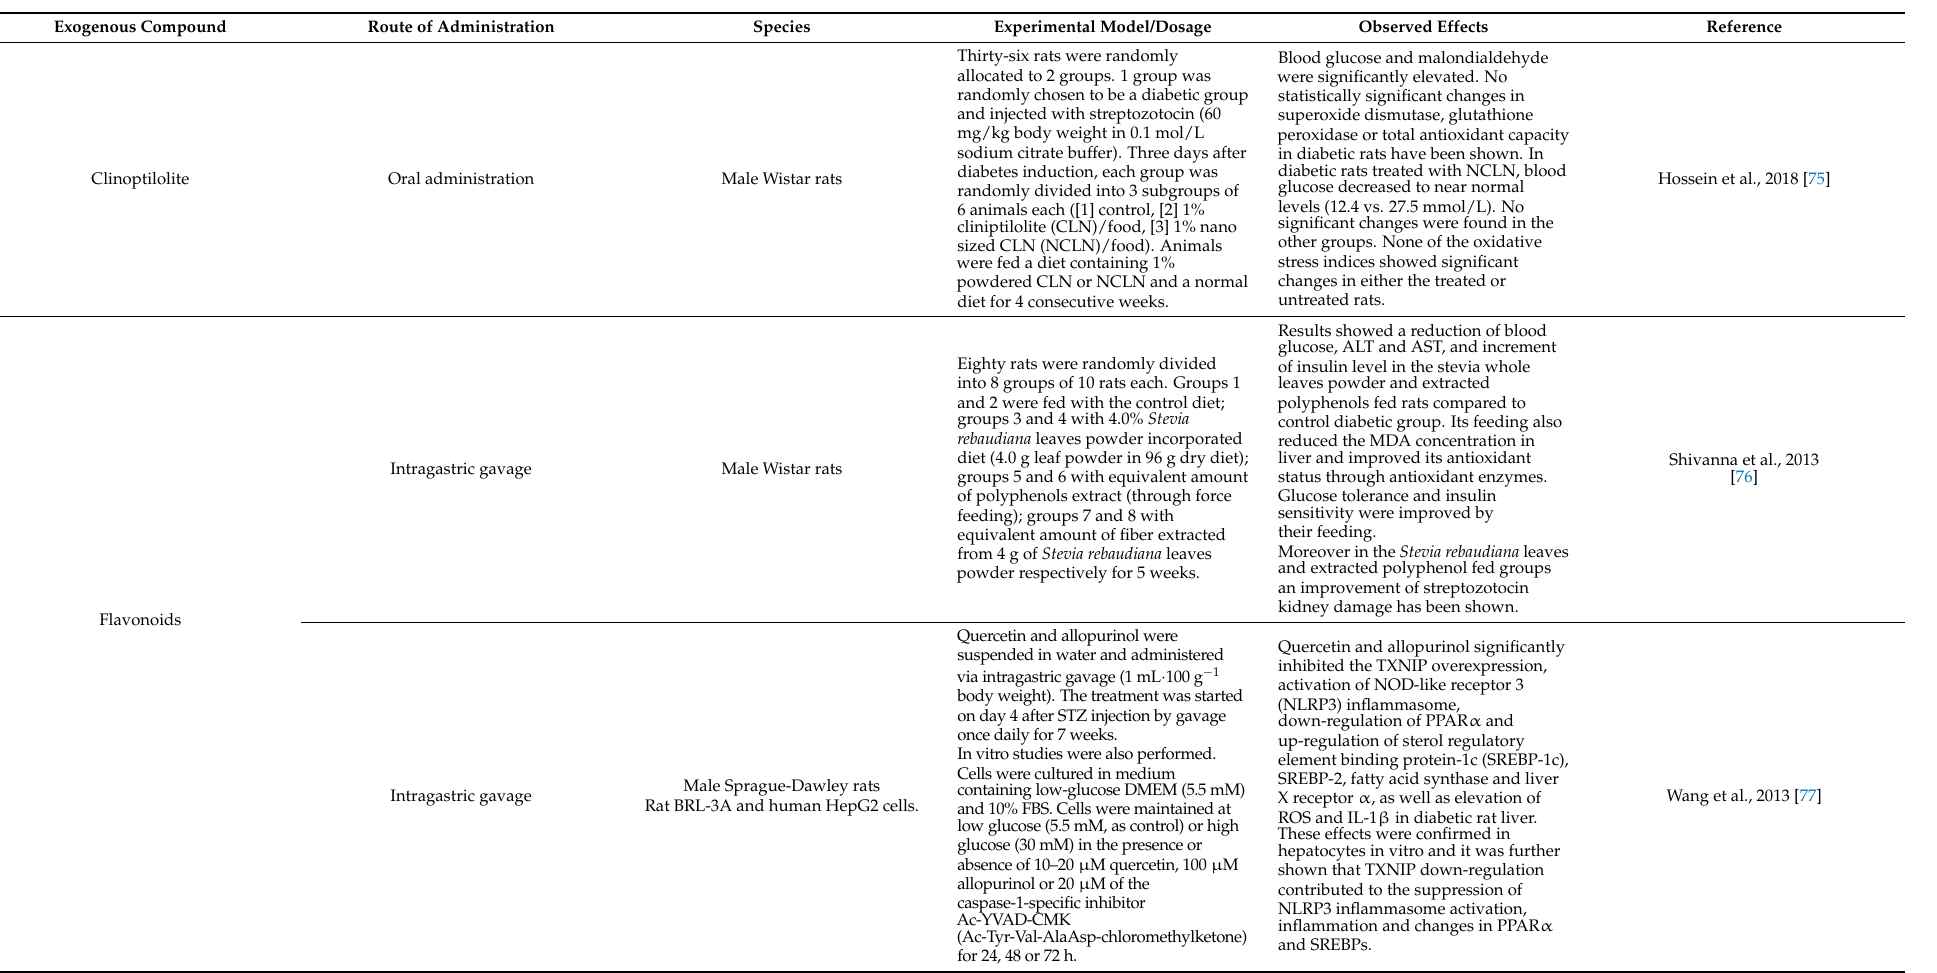
Table 2. Pre-clinical study carried out with selected compounds in experimental models of autoimmune